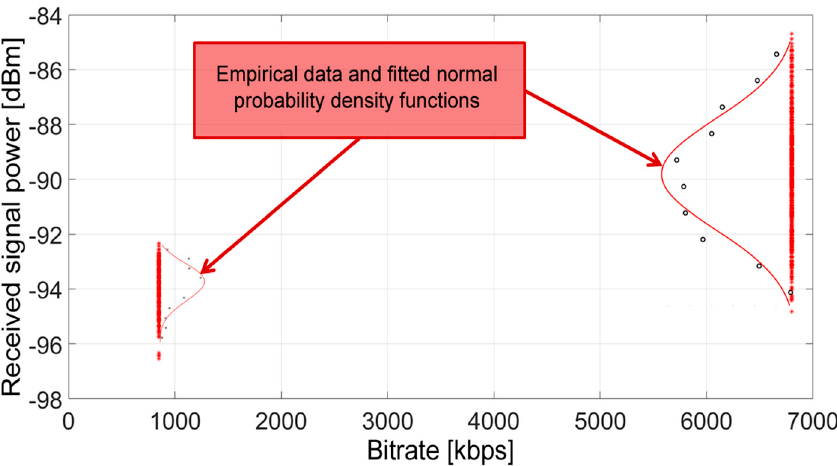
Figure 6. The method for determining the noise characteristics of the UWB interface from the data of empirical measurements for an exemplary packet error rate (PER) = 10 − 3 .